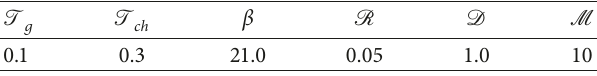
Table 1: Parameter values of one-area LFC-based model (1).